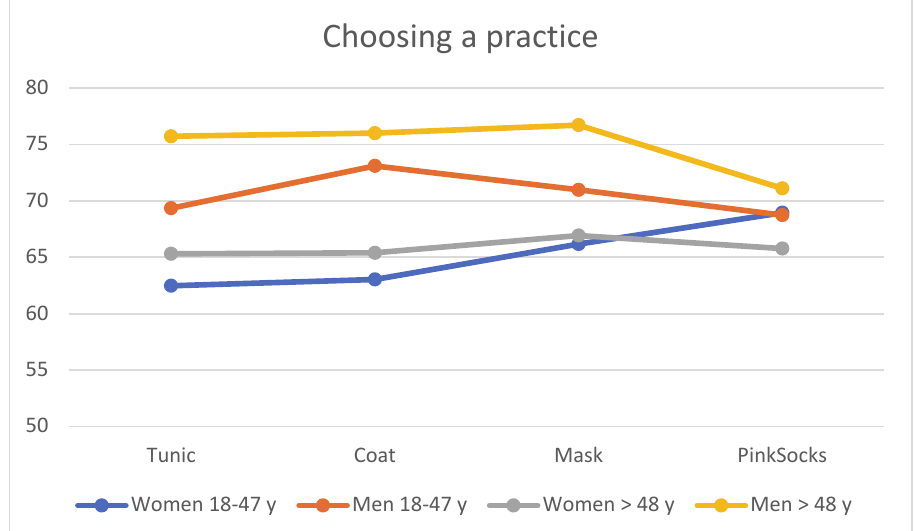
Figure 6. Mean rating of the four photos for choosing a practice by the four subgroups ( n = 906).